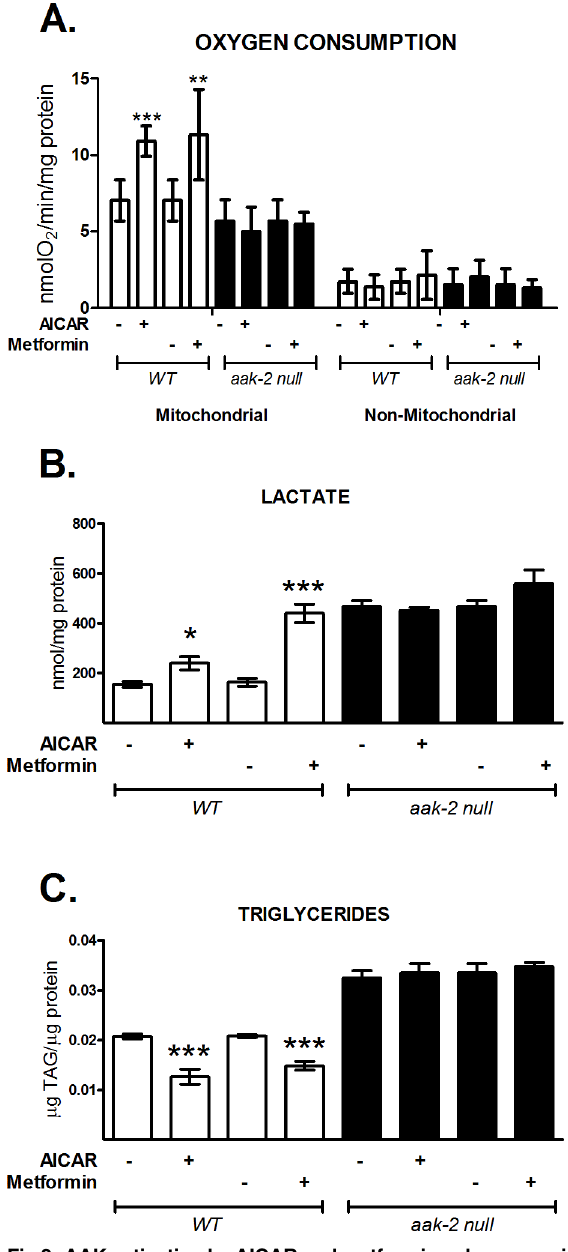
Fig 2. AAK activation by AICAR and metformin enhances oxidative metabolism in C . elegans . N2 (white box) and aak-2 /ok524 (black box) nematode strains were grown to the adult stage and exposed to 1 mM AICAR for 12 h or 50 mM metformin for 24 h. A) Mitochondrial and non-mitochondrial oxygen consumption. B) Lactate concentration and C) Total triglyceride content. Each graph shows the mean ± SEM of three independent experiments. The aak-2 mutant groups showed no change between them. * p < 0.05, ** p < 0.01, *** p < 0.001 vs. untreated group, one-way ANOVA with Bonferroni's post hoc test, using GraphPad